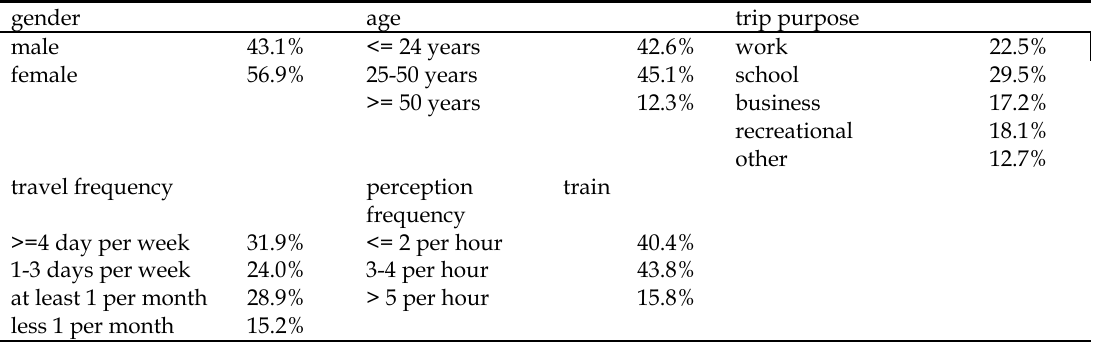
Table 1. Response group characteristics